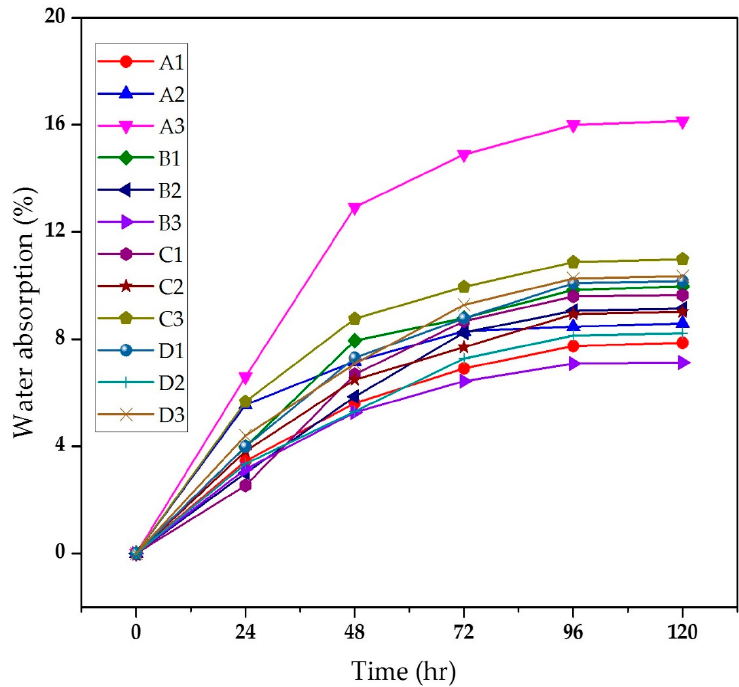
Figure 2. Water absorption (%) of composites .